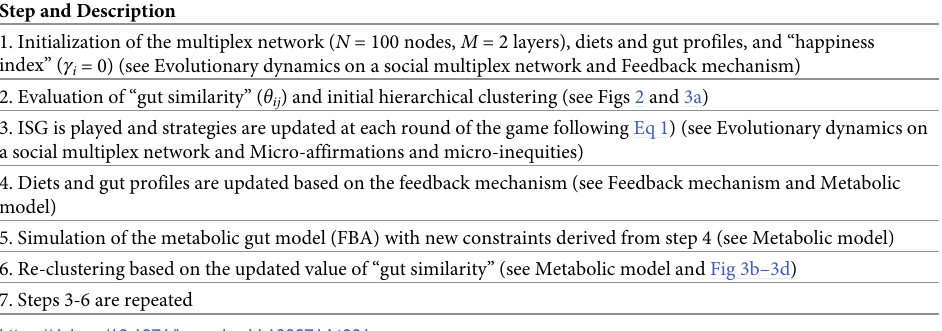
Table 1. Steps of the proposed modeling procedure. We list and briefly describe the various steps of our modeling procedure, indicating the references to the figures and subsections of the section Materials and methods. Step and